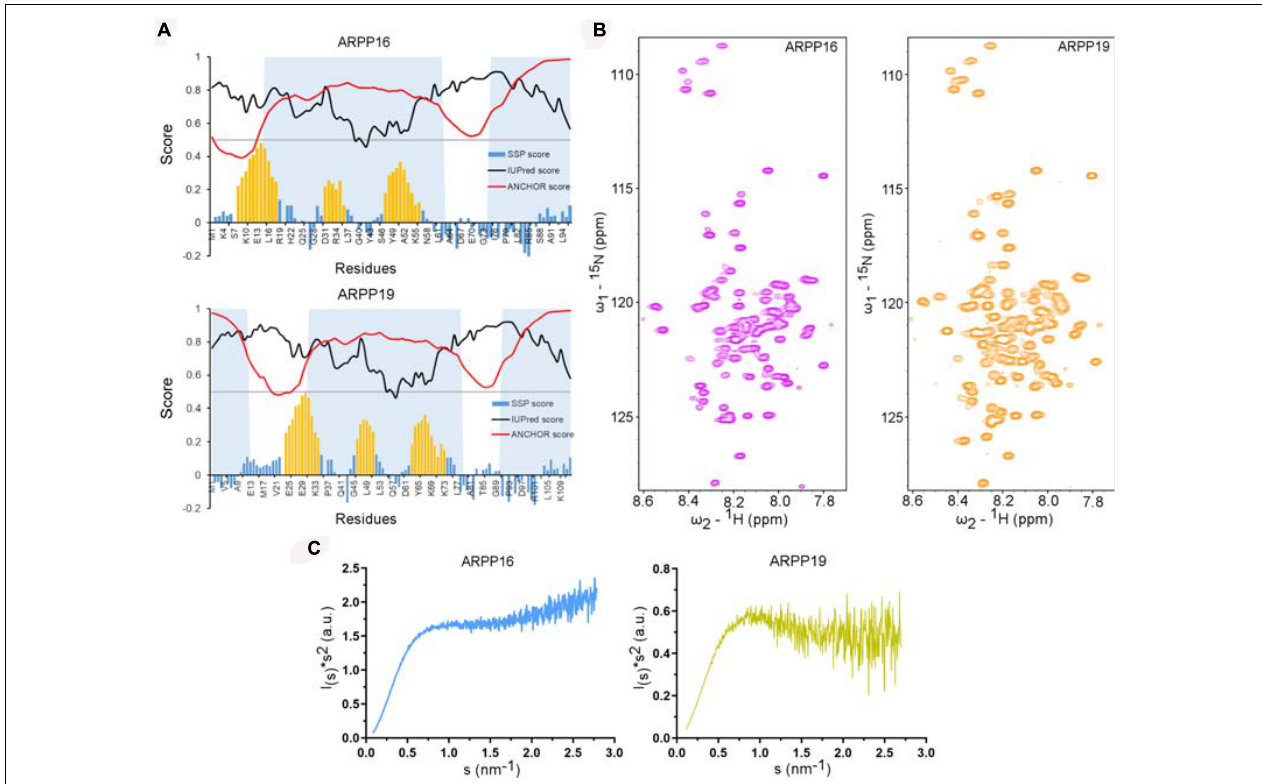
FIGURE 2 | ARPP-19 and ARPP-16 are intrinsically disordered proteins having propensity to form three transient α -helices. (A) IUPRED2A analysis and secondary structure propensity (SSP) calculation of ARPPs. IUPred2 and Anchor2 score are represented with black and red curves, respectively. The disordered prediction score in black highlights disordered nature of ARPPs and disordered binding region prediction score in red suggests presence of multiple disordered binding regions which are shown as shaded region. SSP score for ARPPs calculated using 1 H α , 13 C α , and 13 C β chemical shift shows that both ARPPs have propensity to form three α -helices. The positions of α -helices are highlighted with orange color. (B) The cross peaks in the 2D 15 N-HSQC spectra of uniformly 15 N labeled ARPPs are highly overlapped because of the degeneracy of the proton spectra dispersion indicating that the ARPPs lacks well-defined 3D structure. (C) The Kratky plot calculated from SAXS data exhibits rising curve with increasing angle, which corresponds to the scattering pattern of